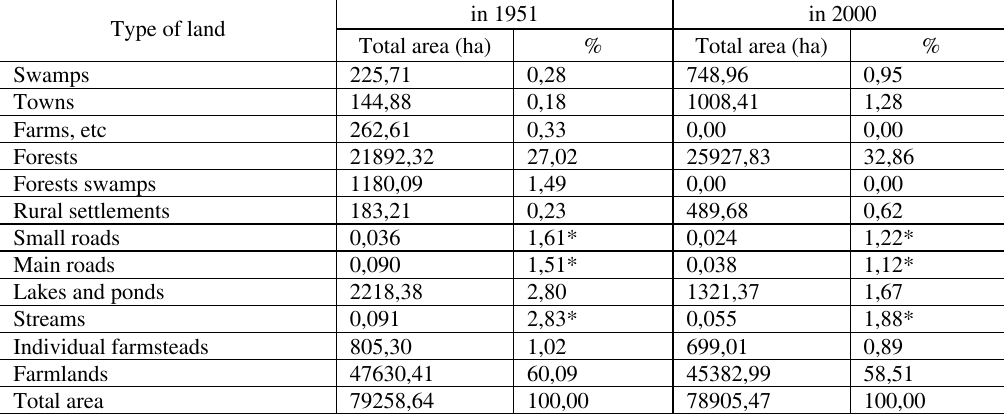
Table 2. Change dynamics of landscape cover structure in reference area of glaciofluvial relief